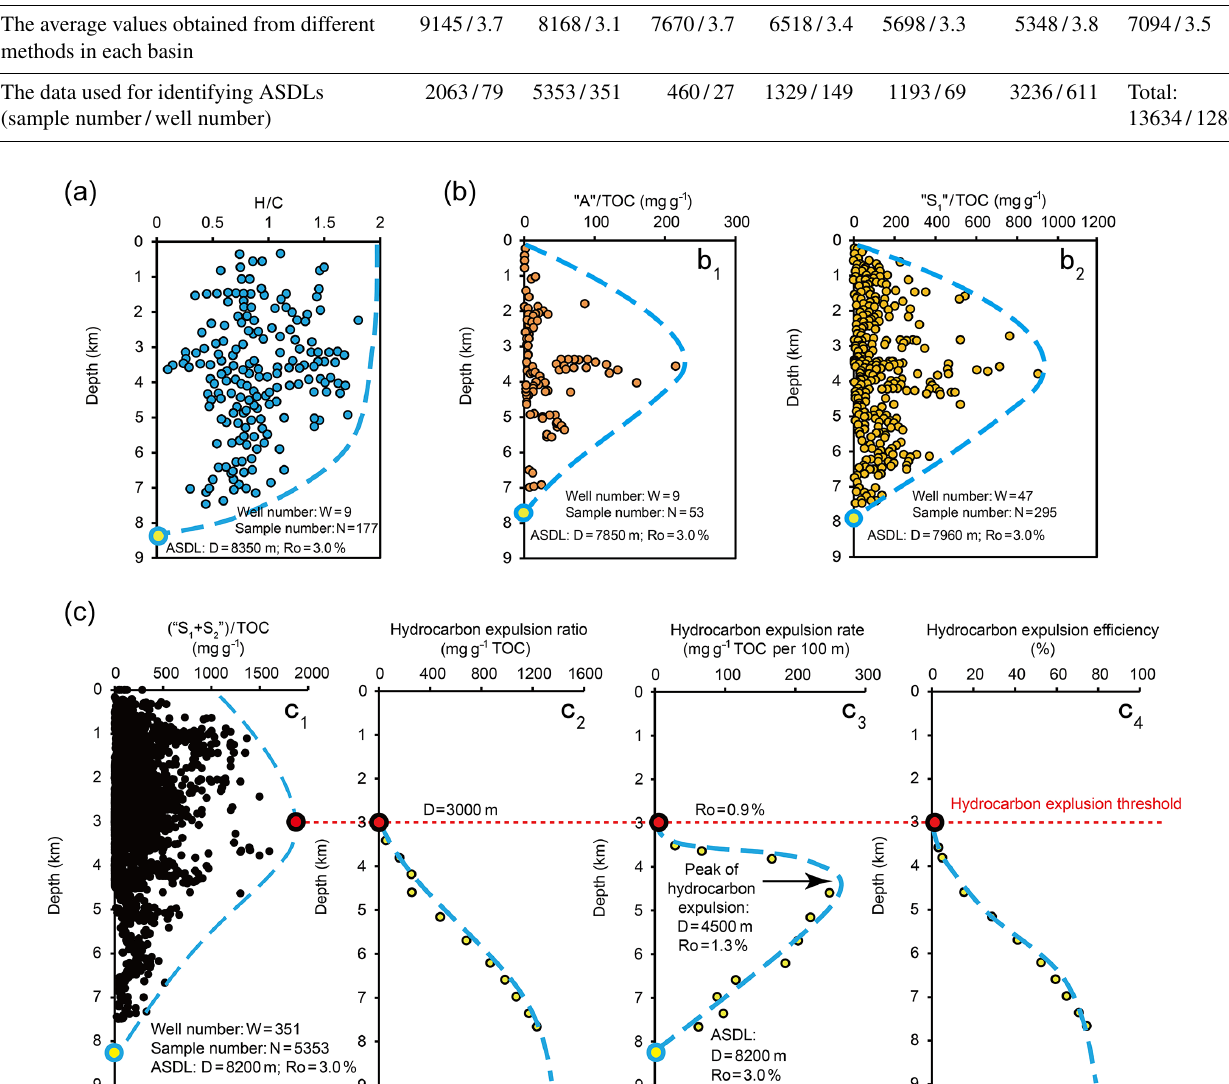
Figure 2. Identification of ASDL in the Junggar Basin using different indicators, including the variation in H / C ratios (a) , residual hydro- carbon amounts (b) , “S 1 + S 2 ” / TOC (c1), Q e (c2), V e (c3), and K e (c4) versus